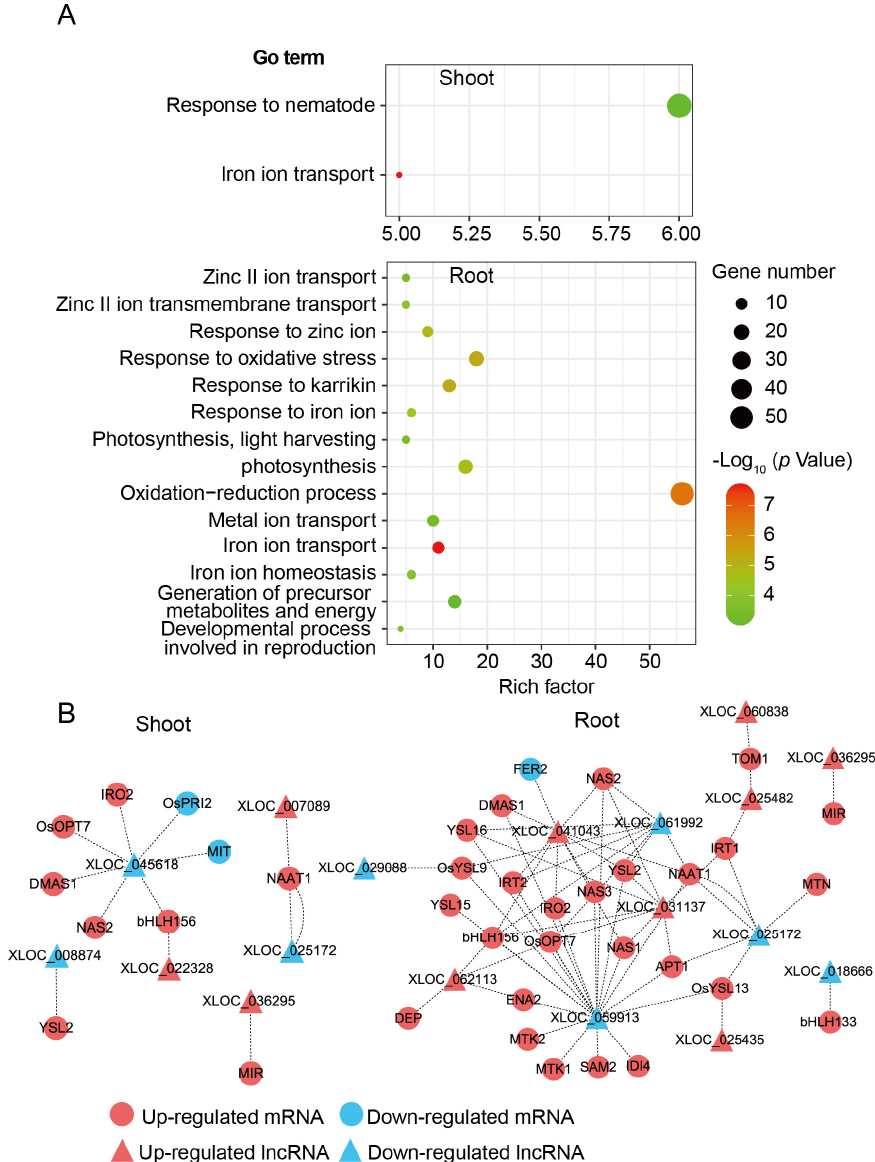
Figure 7. Interaction of DE-lncRNAs with DE-mRNAs. ( A ) Gene ontology (GO) enrichment of DE-mRNAs predicted to interact with DE-lncRNAs in shoot and root ( p < 0.001). Only biological process terms were shown. ( B ) Interaction networks among DE-lncRNAs and Fe-related mRNAs based on complementary pairing of bases in shoot and root. Circles and triangles represent Fe-related mRNAs and DE-lncRNAs, respectively. Red and blue represent upregulated and downregulated, respectively. Dotted line shows the potential interaction between mRNA and lncRNA.